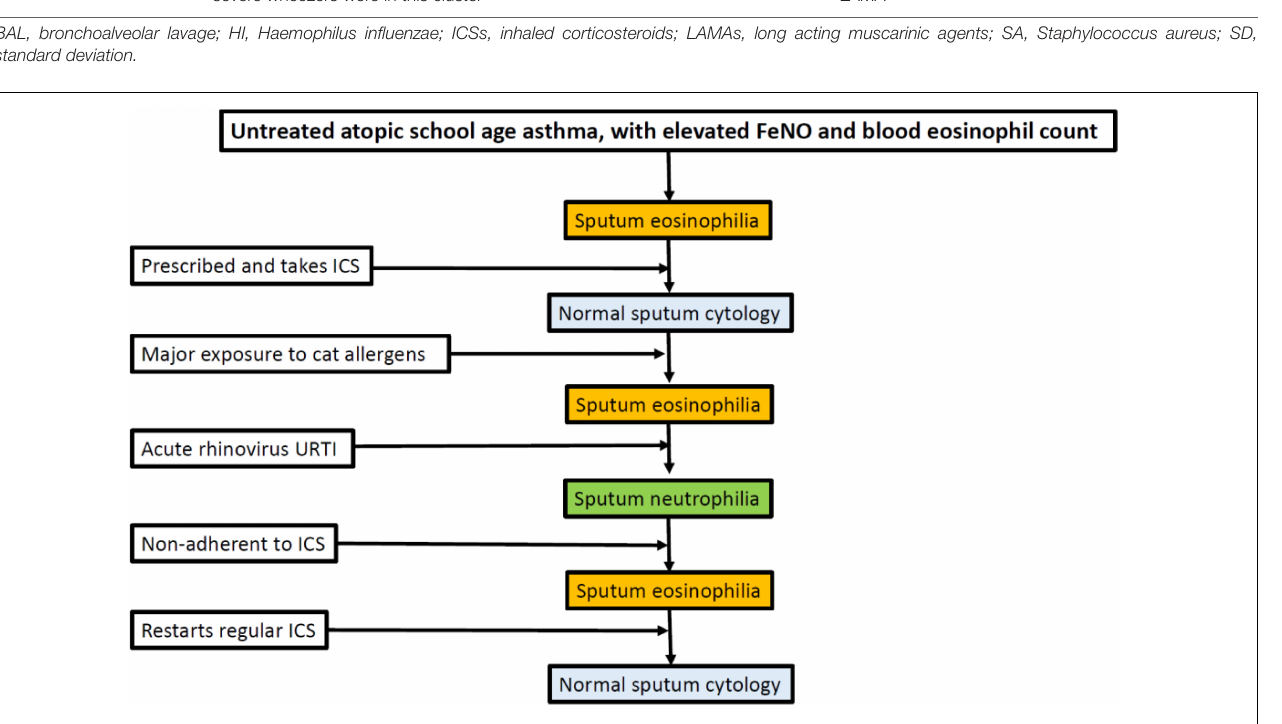
Frontiers in Pediatrics |